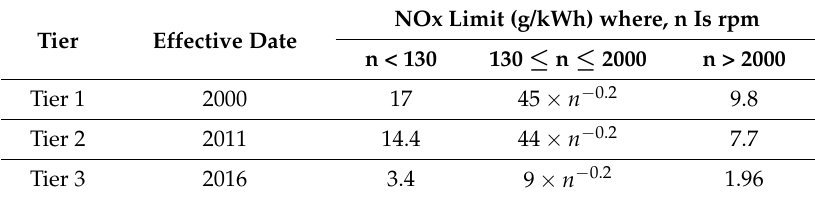
Table 1. NOx limits in MARPOL Annex